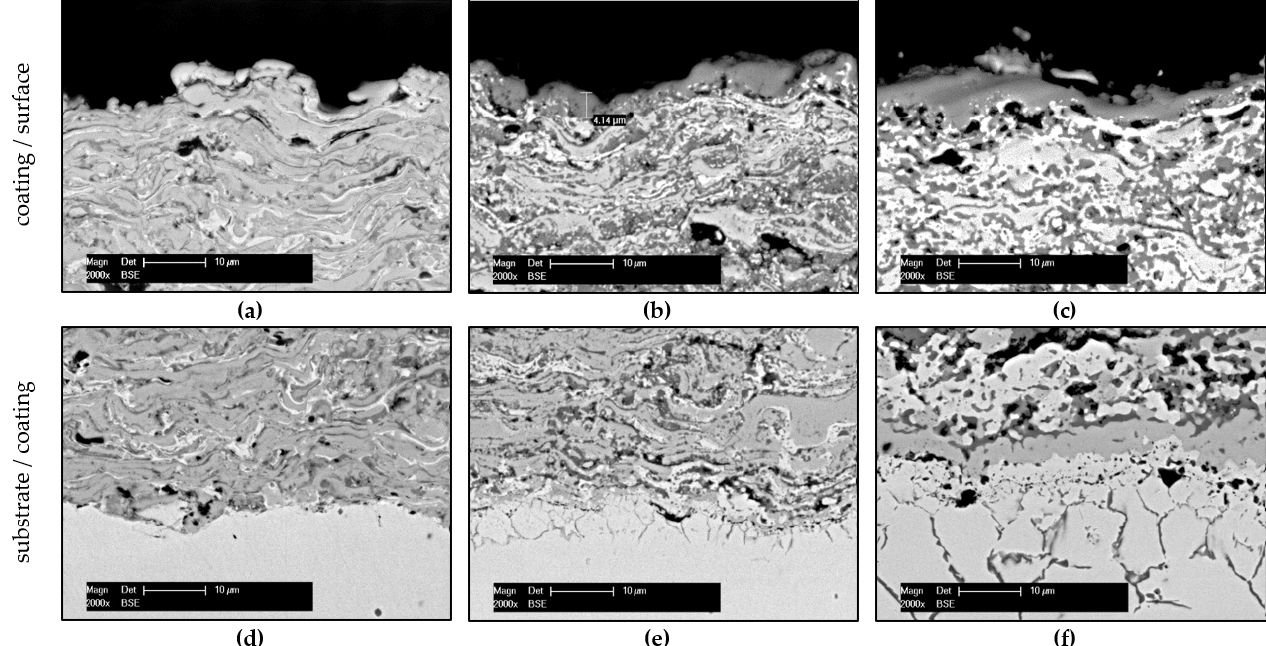
Figure 4. Cross-section micrographs of the Cr-Cr x O y coating ( a , d ) as-sprayed, ( b , e ) heat-treated (t 900°C = 10 h), and ( c , f ) isothermally oxidized (t 900°C = 1200 h).